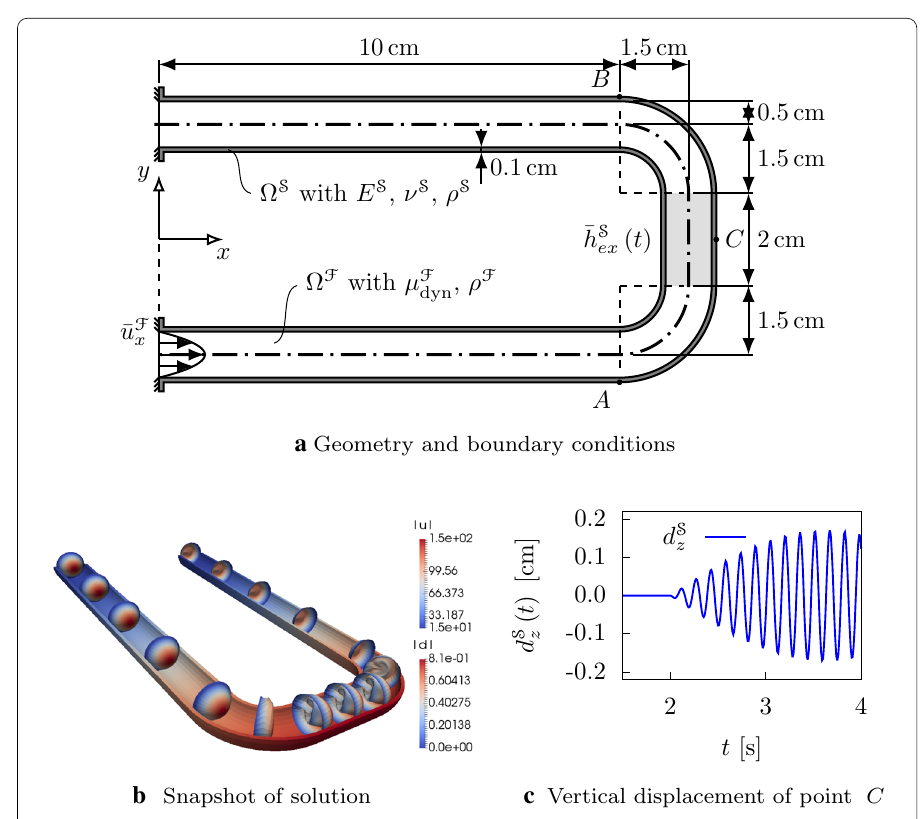
Fig. 8 Coriolis flow meter— Top: The U-shaped pipe with circular cross section is clamped at its inflow and outflow cross sections and filled with fluid. The fluid velocity is prescribed at the inflow, while a traction-free boundary condition is assumed at the outflow. Bottomleft: Snapshot of solution with displacement of the pipe and velocity profiles of the fluid flow. Bottomright: Vertical displacement over time ⎧ ⎨ 0 if 0 ≤ t < t 2 ¯ h S (cid:4) (cid:5) ( t ) = ⎩ ex ˆ h S ω S t sin otherwise ex ex = 2 . 0 · 10 − 1 g / cm · s 2 ,theangularfrequency ω S withtheamplitude ˆ h S ex